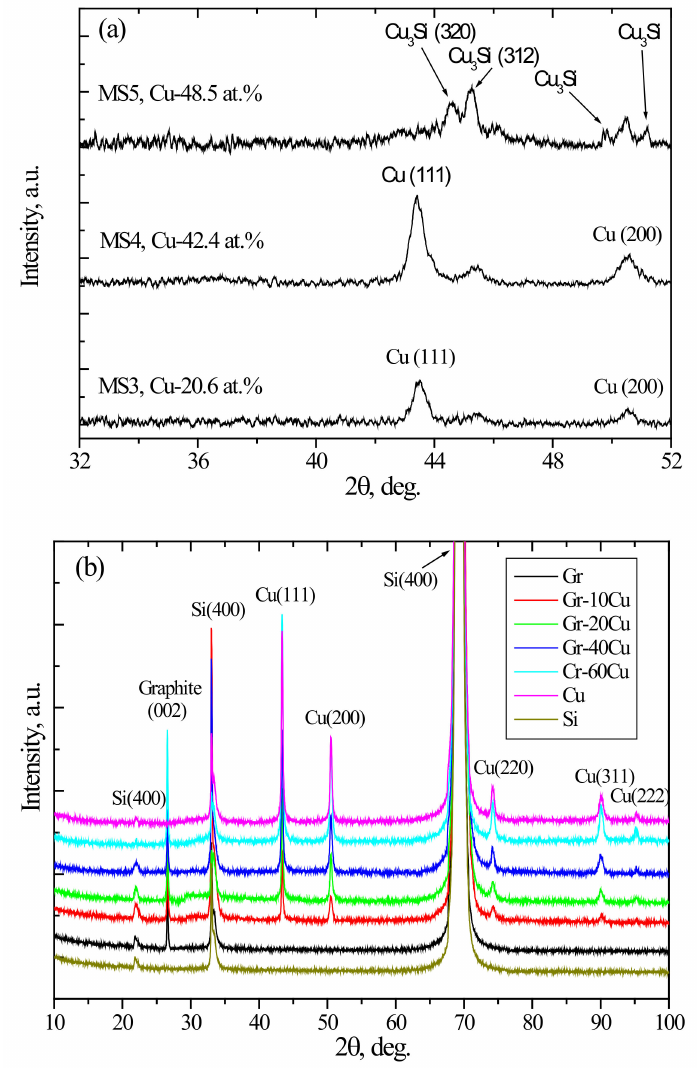
Figure 3. XRD patterns of the films deposited using ( a ) magnetron sputtering and ( b ) plasma